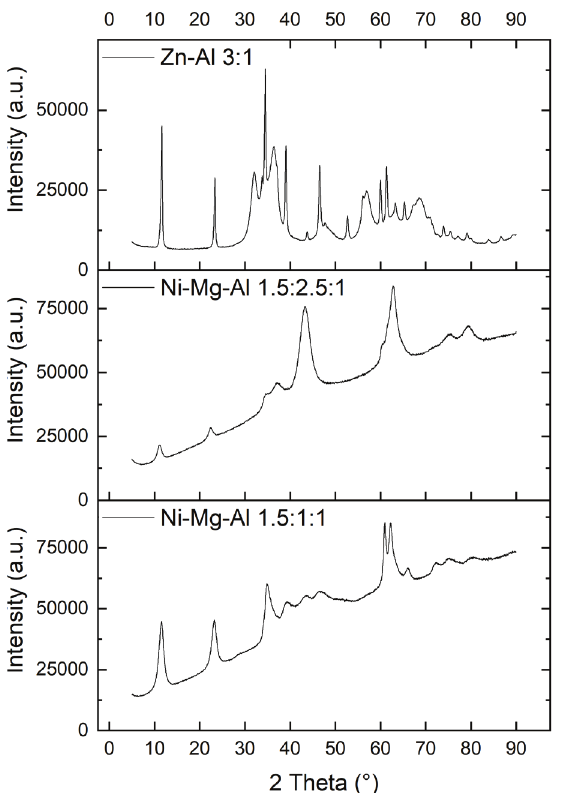
Fig. 4 – X-ray diffractograms of Mg-Al 2:1 material modi- fied with different